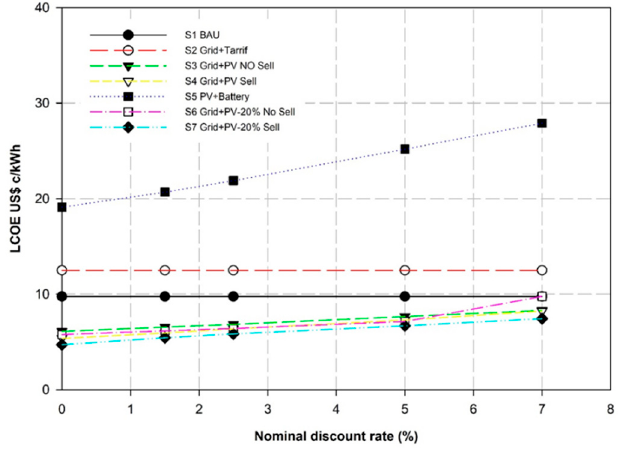
Figure 11. Levelised cost of energy for all scenarios.